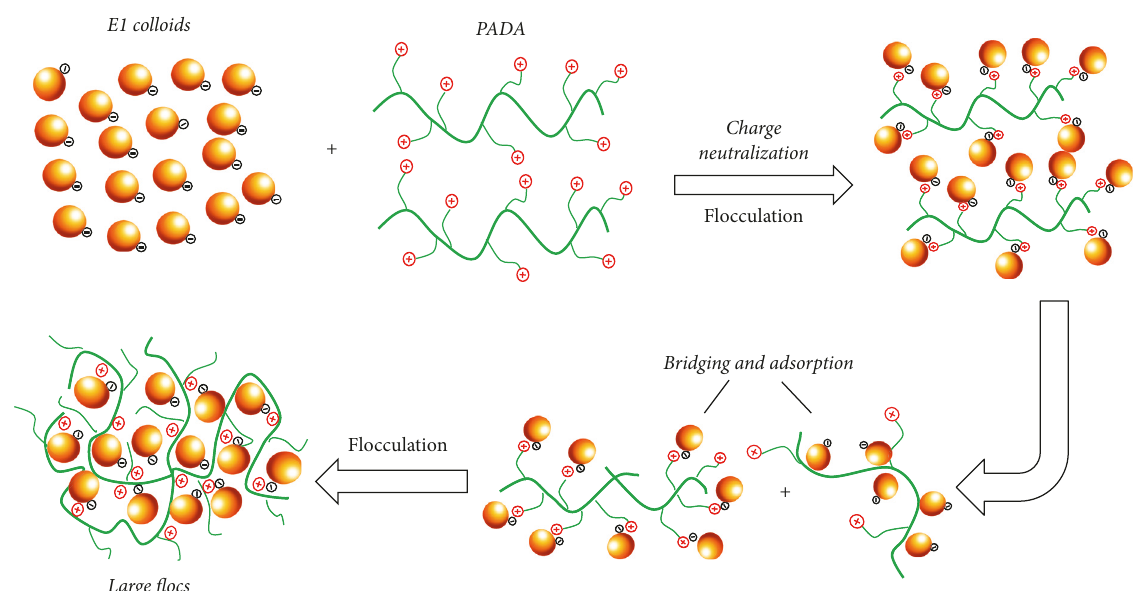
Figure 12: The possible flocculation mechanism of the